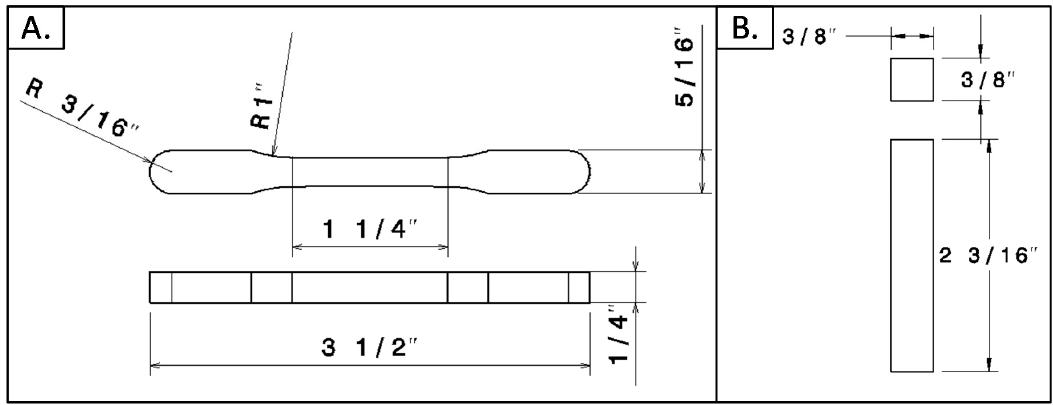
Figure 4. Specimens geometry, ( A ) tensile test specimen [18] and ( B ) unnotched Charpy impact specimen [19].